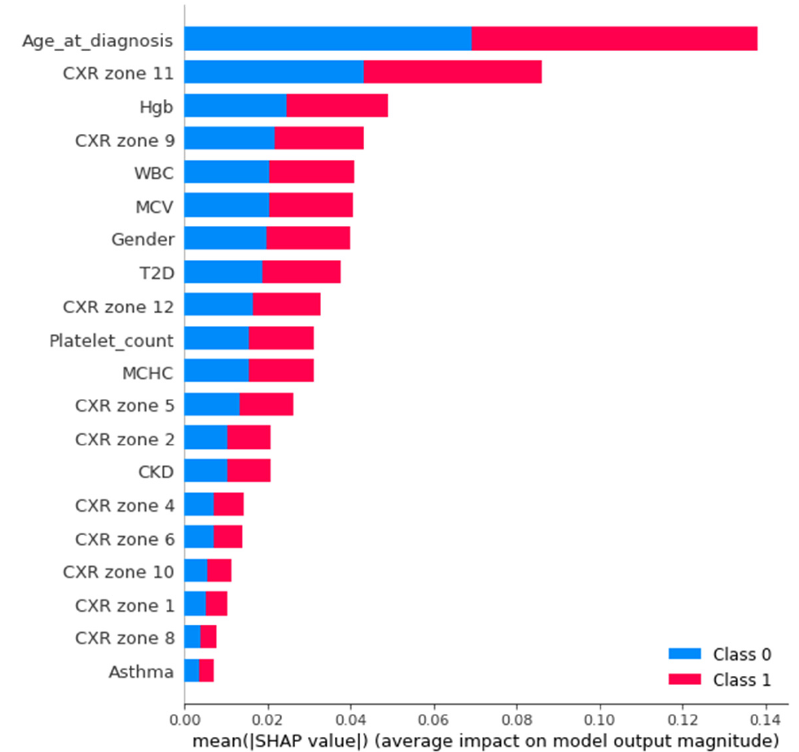
Figure 8. Mean (SHAP value) for the prediction of mortality (Case 1).